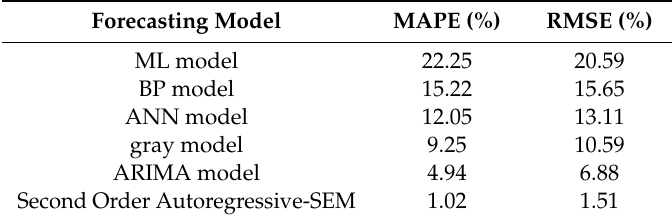
Table 4. The performance monitoring of the forecasting models.